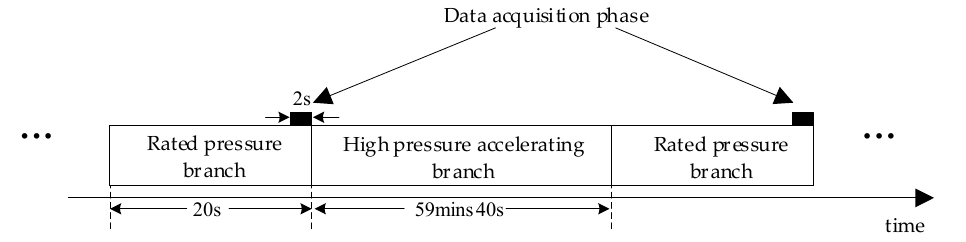
Figure 8. Vibration signal sampling settings.